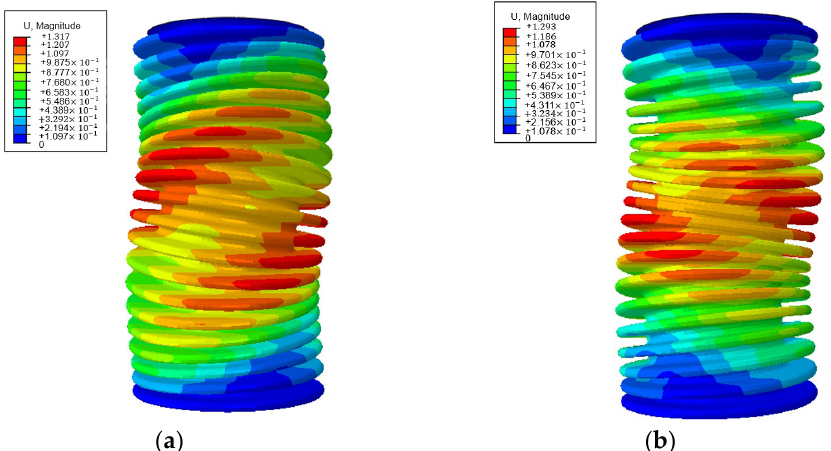
Figure 9. Column instability of the two types of bellows (convolution number was larger than 10); ( a ) buckling mode of toroid bellows and ( b ) buckling mode of spiral bellows.